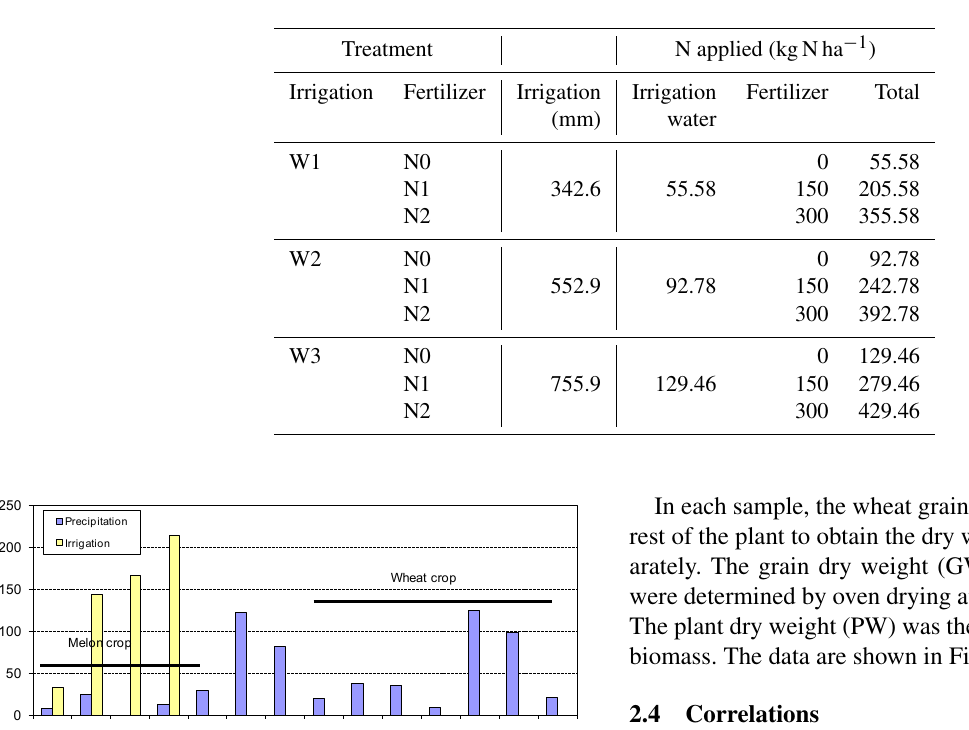
Table 1. The treatments applied to the melon crop, total irrigation (applied irrigation, taking initial establishment irrigation into account, in the different treatments: 60 ETc (W1), 100 ETc (W2) and 140% ETc (W3); 15 to 104 DAT) and applied nitrogen information. From Milne et al. (2010) with permission.